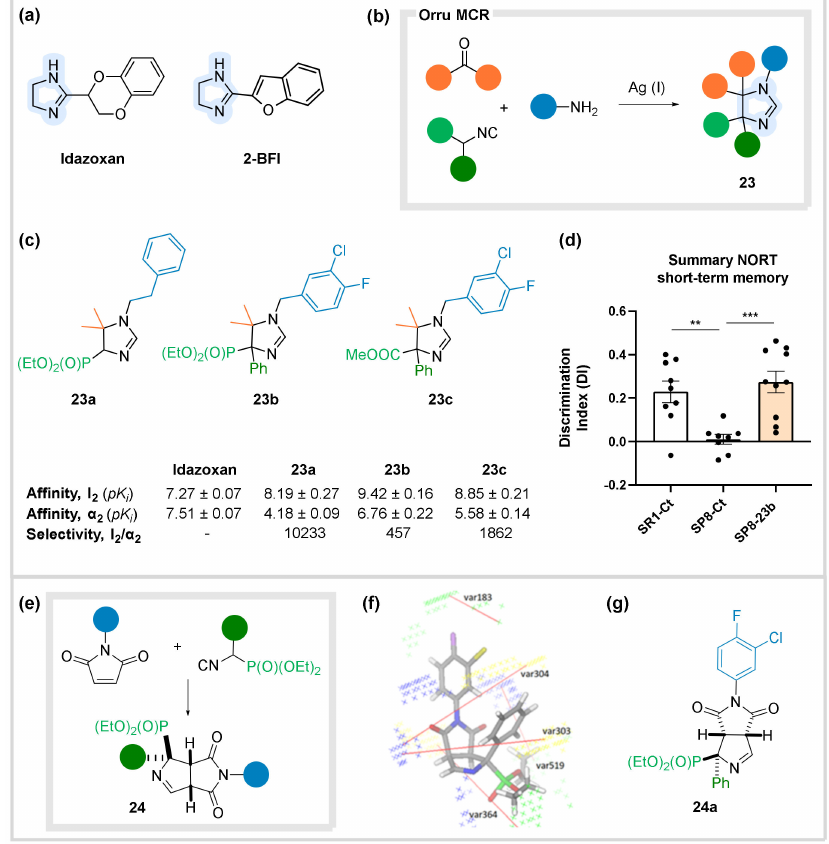
Figure 9. I 2 Imidazoline receptors. ( a ) Structure of known I 2 IR ligands. ( b ) MCR access to substituted 2-imidazolines 23 . ( c ) Structure and binding affinities of the selected compounds. ( d ) In vivo data of compound 23b . ( e ) Condensation between maleimides and PhosMIC derivatives leading to new I 2 -IR ligands 24 . ( f ) 3D-QSAR series 24 . ( g ) Structure of the selected analogue 24a . Values represented in ( d ) are mean ± Standard error of the mean (SEM); n = 36 (SR1-Ct n = 11; SP8-Ct n = 11; SP8-23b n = 14). ** p < 0.01; *** p <